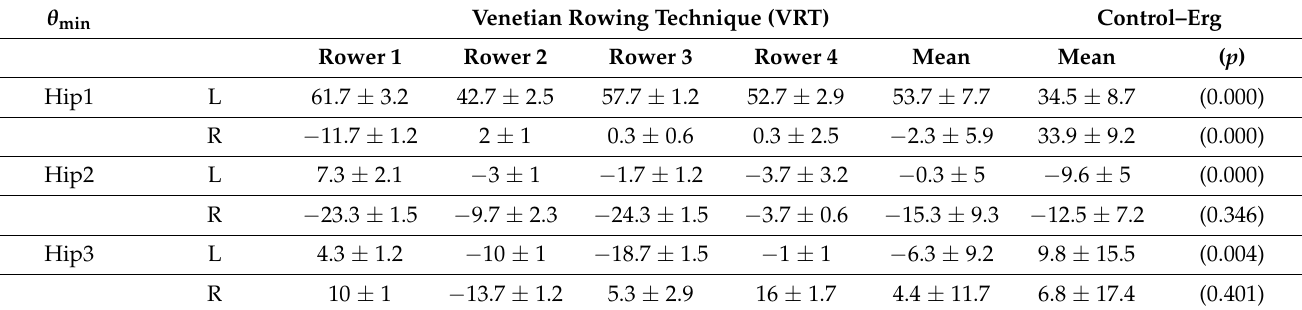
Table 5. The minimum values, θ min , of the hip, knee and ankle angles measured for the Venetian style rowing technique, in degrees, ± 1 s.d., for the individual rowers 1–4, their mean, and its equivalent mean value for standard ergometer rowing, with p -value for these two means reported in